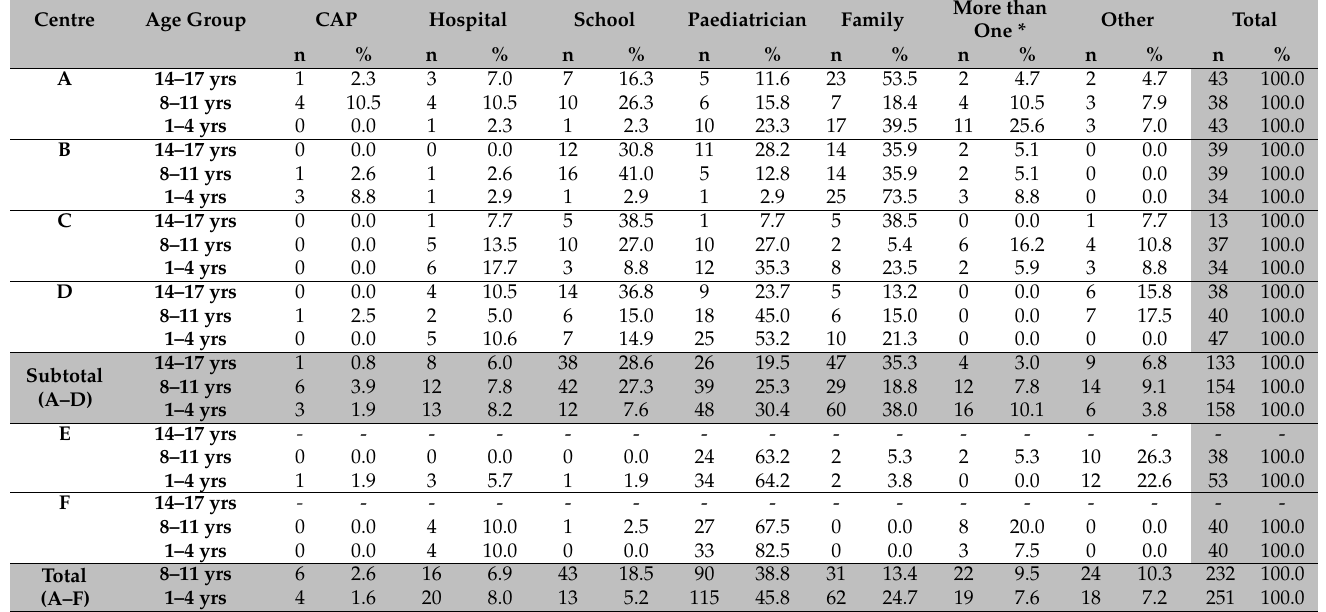
Table 3. Frequency of subjects by referrer, CAMH unit and age